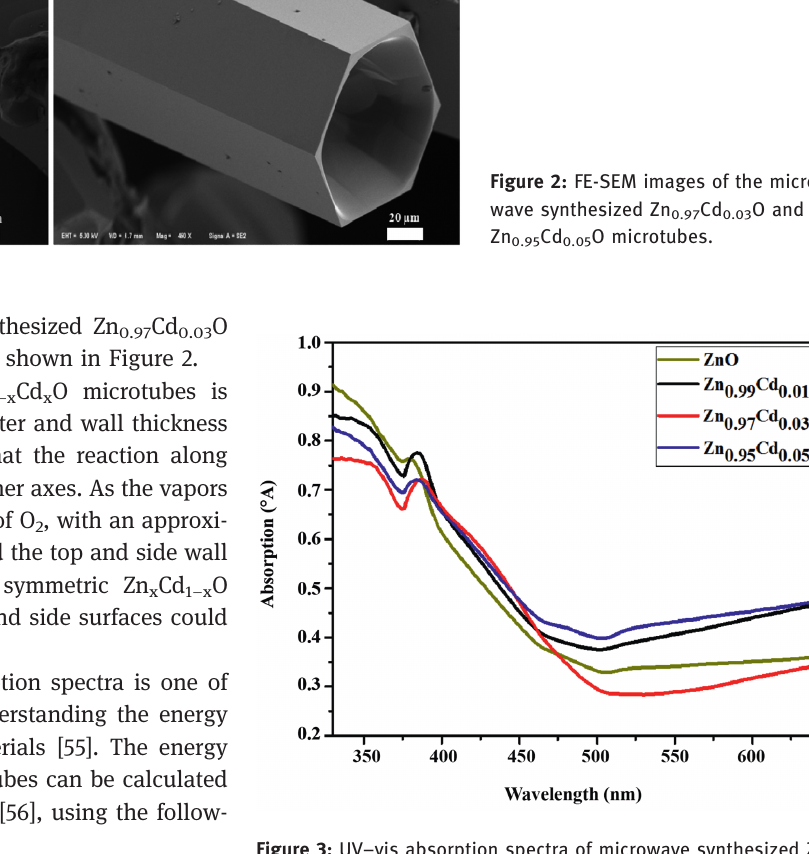
Figure 3: UV – vis absorption spectra of microwave synthesized Zn 1 – x Cd x O